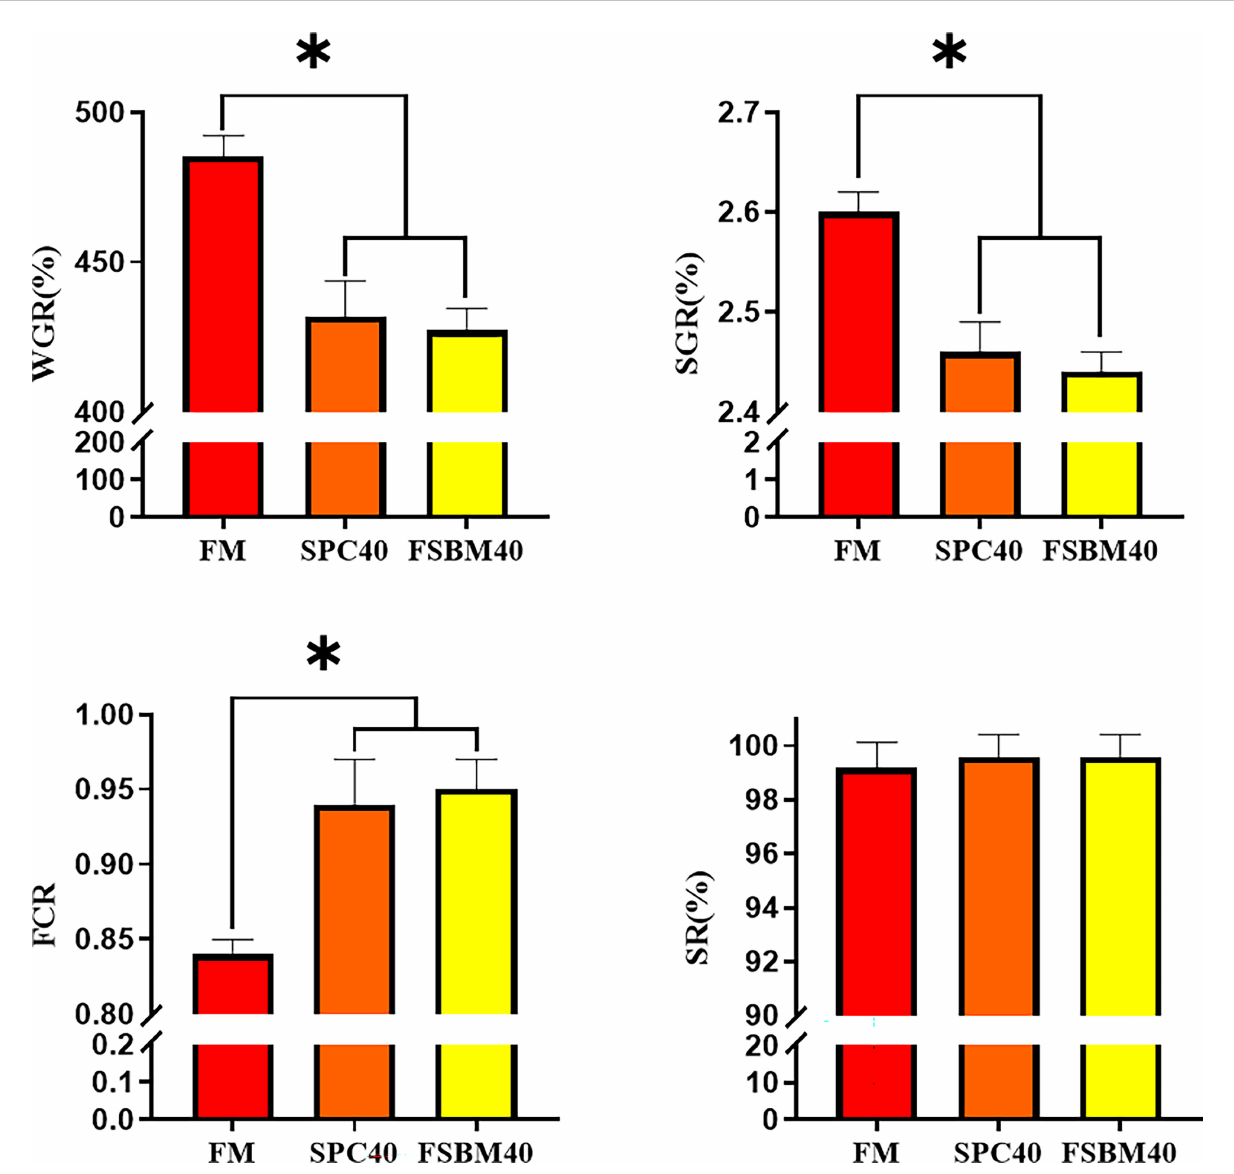
FIGURE 1 Effect of soybean protein concentrate or fermented soybean meal substitution of 40% fi sh meal protein on the growth of pearl gentian grouper (n=4). WGR, weight gain rate; SGR, speci fi c growth rate; FCR, feed conversion ratio; SR, survival rates; * P < 0.05.